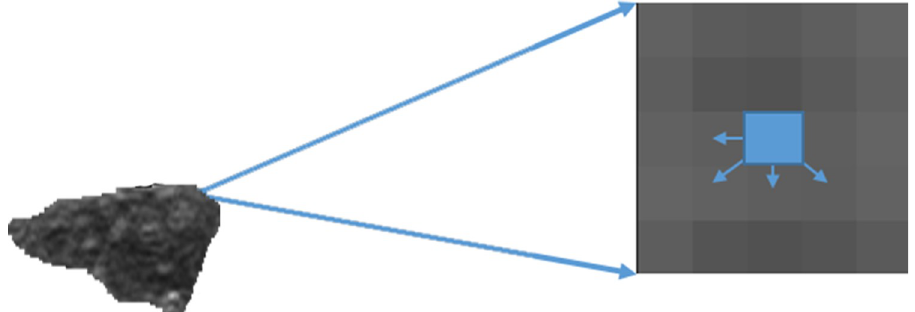
Fig 2. The illustration of texture analysis considering neighboring pixel pairs of four directions: 0˚, 45˚, 90˚, and 135˚ and distance = 1.